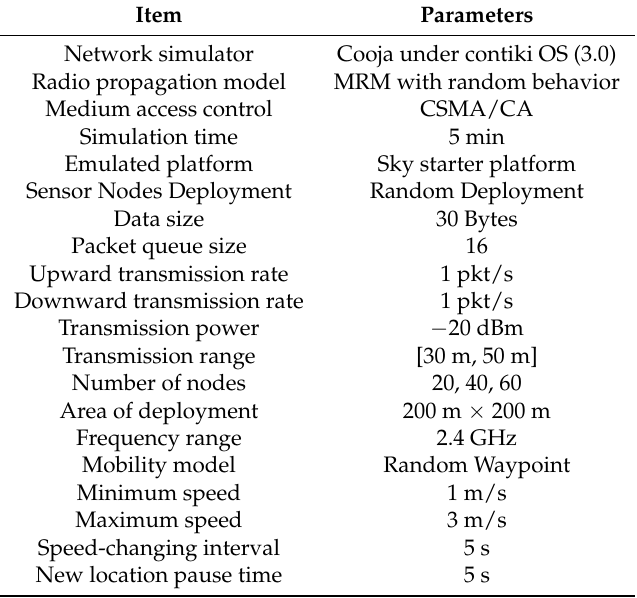
Table 1. Simulation